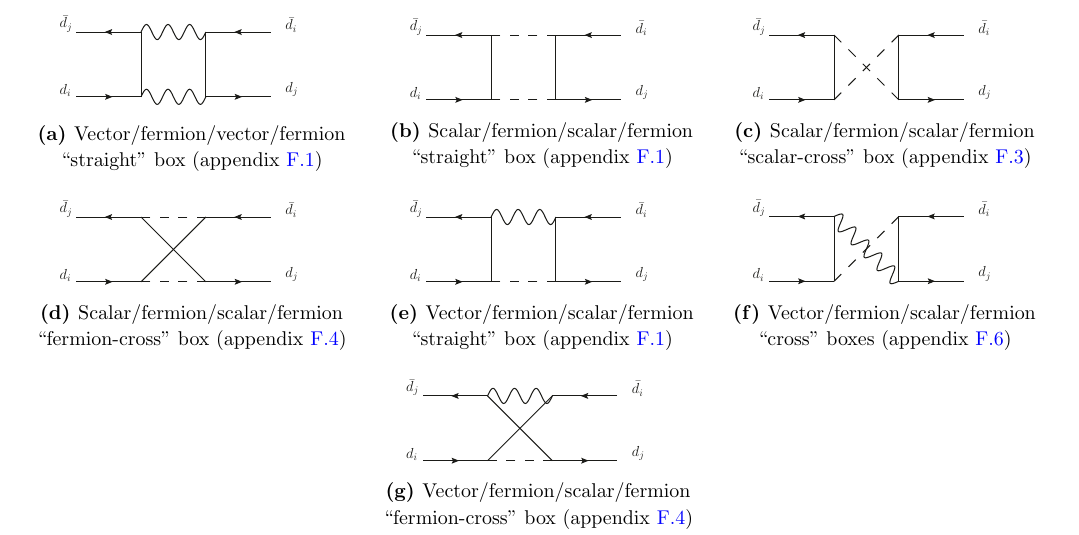
Figure 2. The topologies of box diagrams that appear in the neutral mesons mixing with the